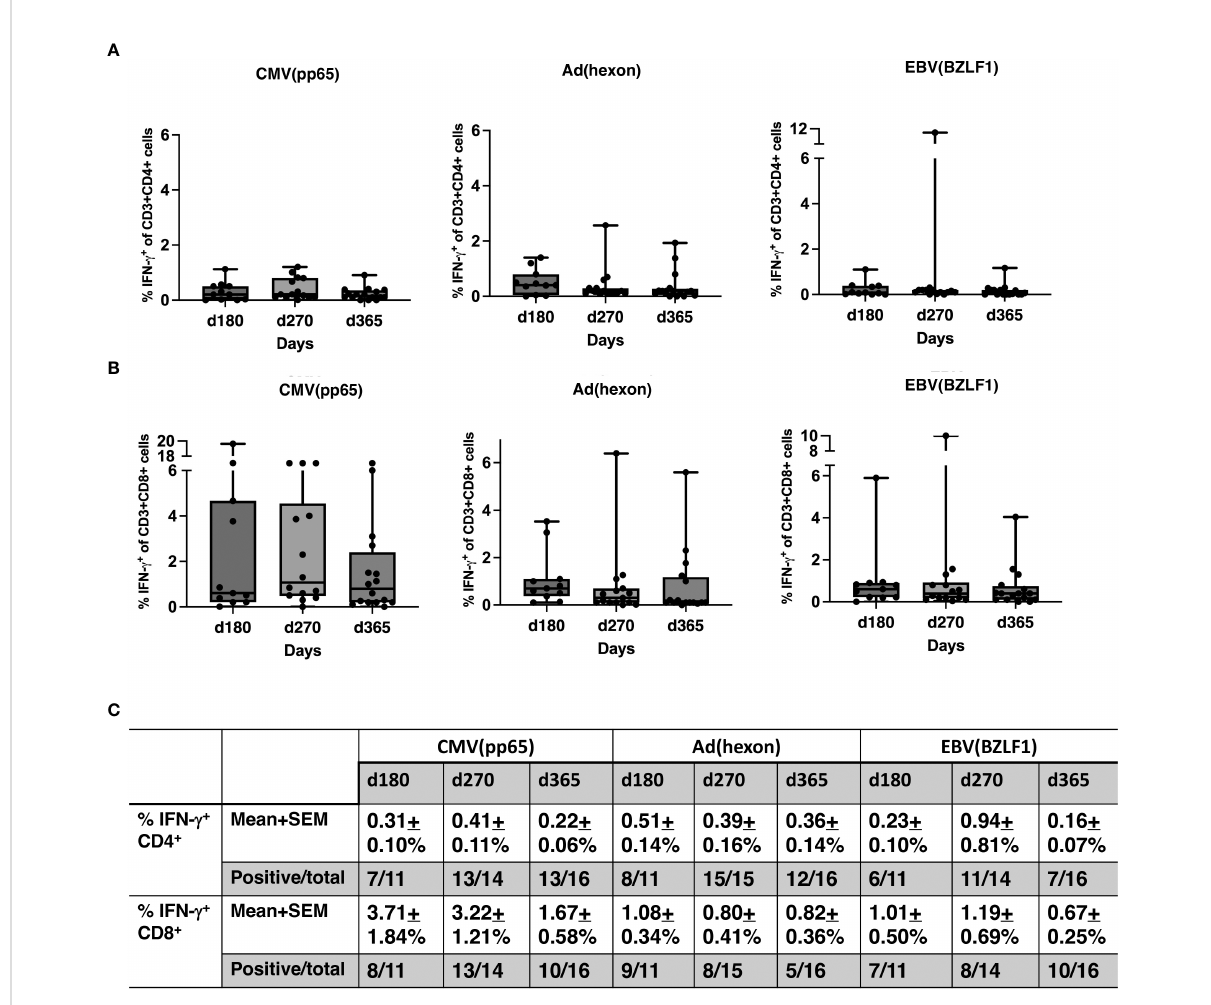
FIGURE 6 T-cell responses to viral antigens. (A) Percentage of IFN- g + CD4 cells in response to CMV (pp65), ADV (hexon), and EBV (BZLF1) shown in box and whisker plots. (B) Percentage IFN- g + CD8 cells in response to CMV (pp65), ADV (hexon), and EBV (BZLF1) shown in box and whisker plots. (C) Summaries of the % IFN- g + of CD4 cells (mean ± SEM), the % IFN- g + of CD8 cells (mean ± SEM), and the numbers of positive responses in response to CMV(pp65), ADV (hexon), and EBV (BZLF1) at day 180, day 270 and day 365. PBMNC, peripheral blood mononuclear cells; n, number; INF, interferon; CMV, cytomegalovirus; ADV, adenovirus; EBV, Epstein-Barr